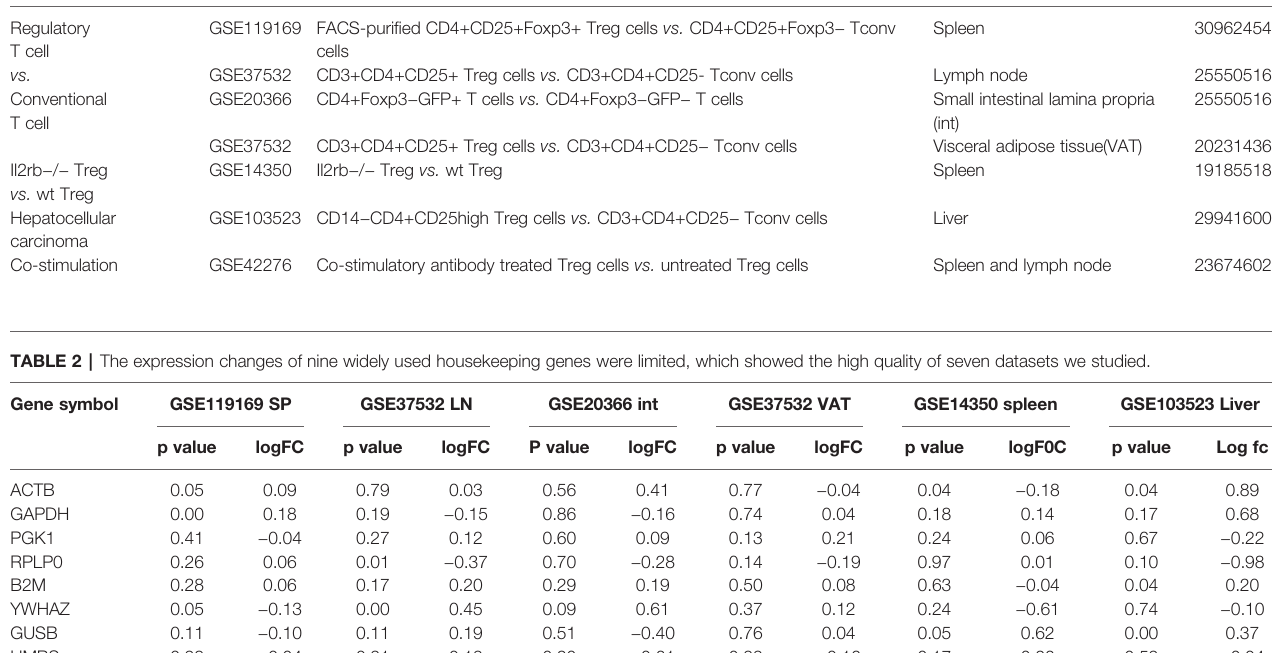
TABLE 1 | Seven microarray datasets were analyzed in our study, which were collected from the NIH GEO Database (https://www.ncbi.nlm.nih.gov/geo/) database and were associated with expression changes of regulatory T cells (Treg) versus ( vs. ) conventional T cell (Tconv). Category GEO ID